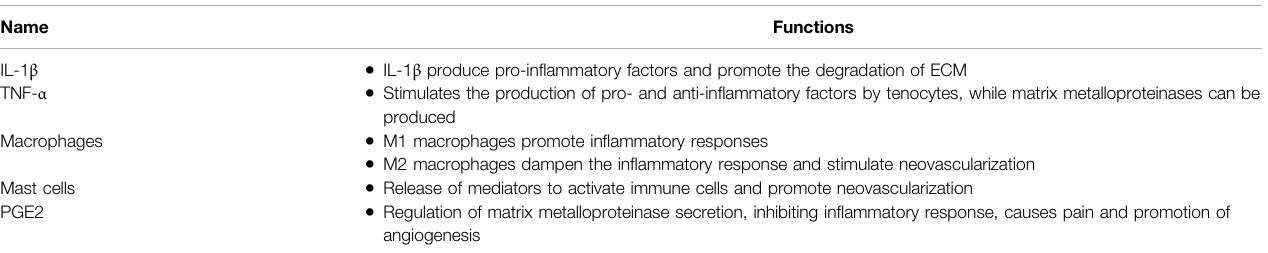
TABLE 2 | The role of in fl ammatory mediators and immune cells in tendon injury IL-1 β , Interleukin-1 β ; TNF- α , tumor necrosis factor- α ; PGE2, prostaglandin